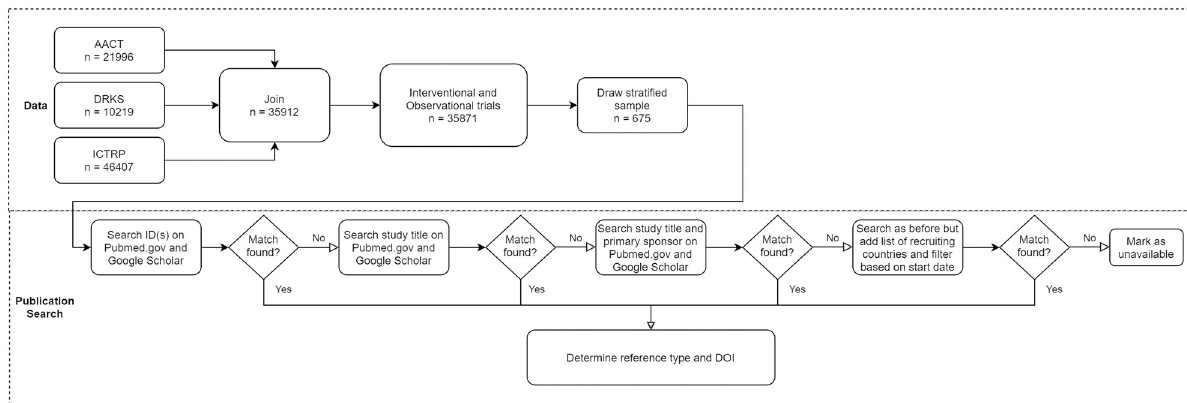
Fig 1. Procedure for data joining and publication